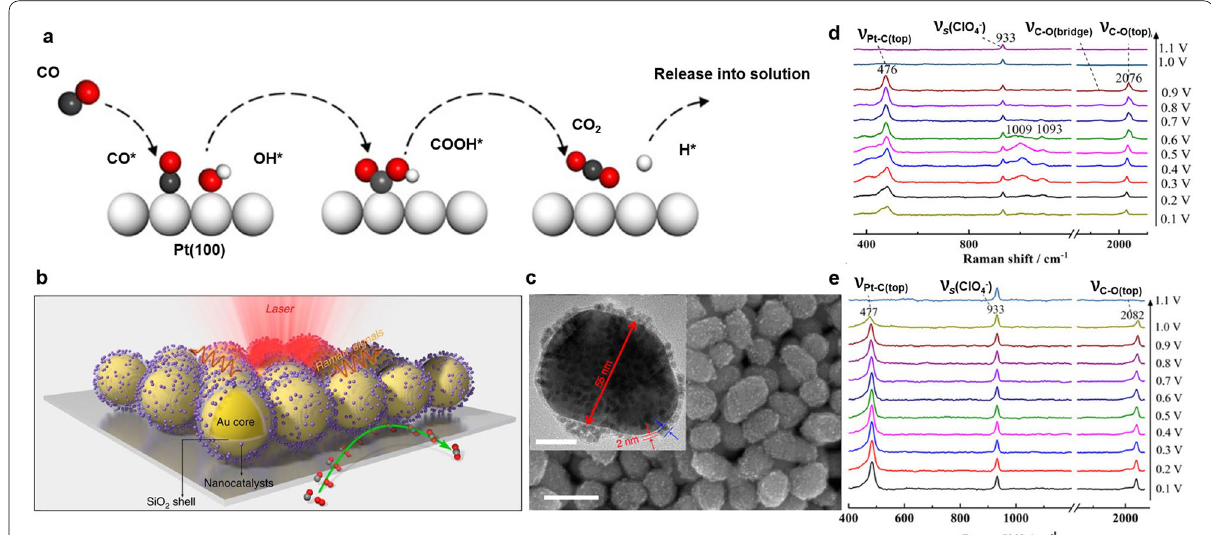
Fig. 8 a The proposed mechanism of CO electrooxidation on the Pt(100) surface, reproduced with permission from [65]. Copyright (2020) Wiley-VCG GmbH. b The satellite structure composed of Au core/silica shells and nanocatalysts. High density of interfaces between the SHINs and nanocatalysts allow for high intensity of SERS signal. c The SEM images of the satellite structure (inset picture: TEM image of the satellite structure), reproduced with permission from [71]. Copyright (2017) Springer Nature Limited. SHINERS spectra of CO electrooxidation on the c Pt(100) and d Pt(110) surfaces in 0.1 M HClO 4 solution saturated with CO, reproduced with permission from [65]. Copyright (2020) Wiley-VCG